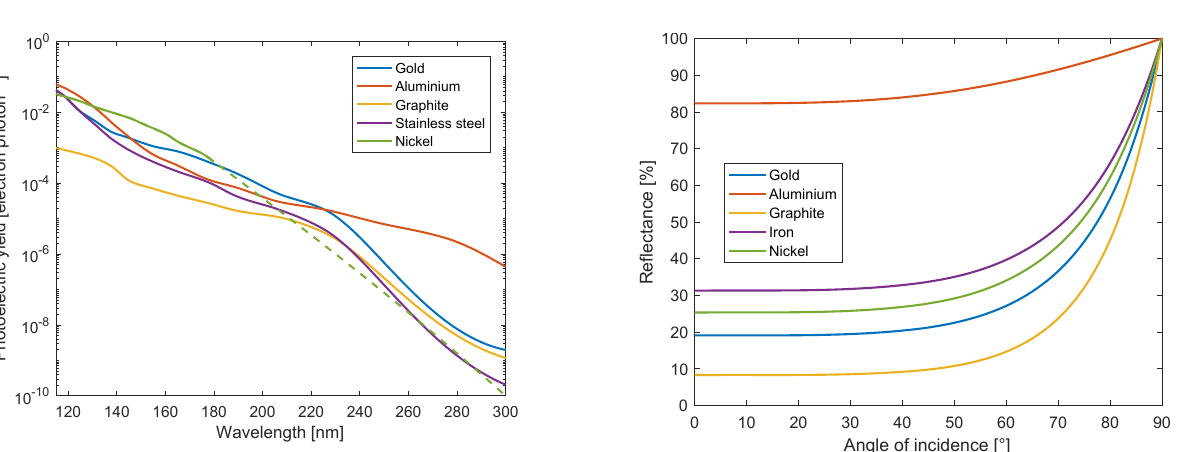
Figure 6. Reflectance at the wavelength of the Lyman-alpha (121nm), as a function of angle of incidence, for each of the five